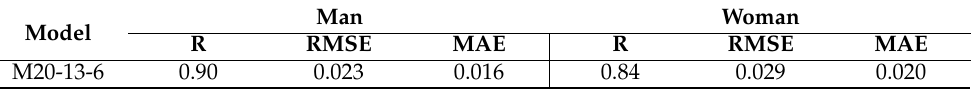
Table 7. The best selected model in which the gender was discriminated.